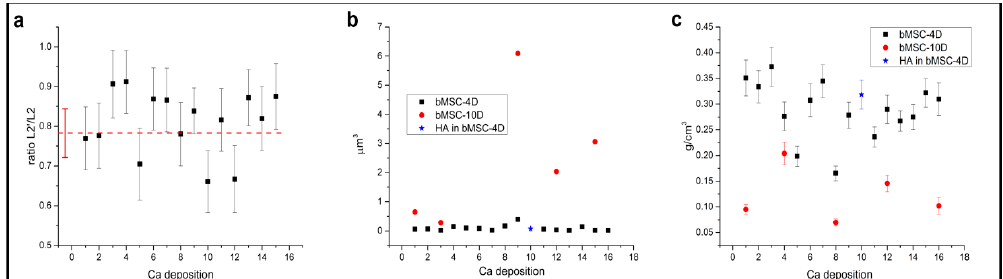
Figure 7. ( a ) Ratio values of the pre-peak L 2 ′ to the L 2 peak (L2 ′ /L2) calculated for Ca carbonates-rich depositions in bMSC-4D. These values are compared with the one obtained from pure biological calcite reference spectrum (dashed line in red). All the measured ratios are compatible within the error with the one estimated from the reference sample, strongly supporting the hypothesis of presence in the observed depositions of crystalline calcite crystals. ( b ) Ca depositions volume values in bMSC obtained using the reconstructed volumes from cryoSXT at the Ca L 3 edge. ( c ) Ca content in g/cm 3 calculated for the depositions characterized with cryoSXT at Ca L edge.